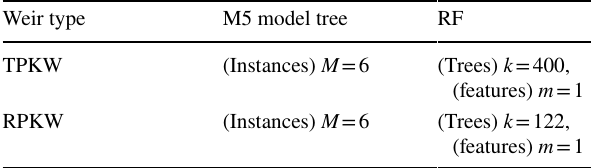
Table 2 User defined parameters for modelling Weir type